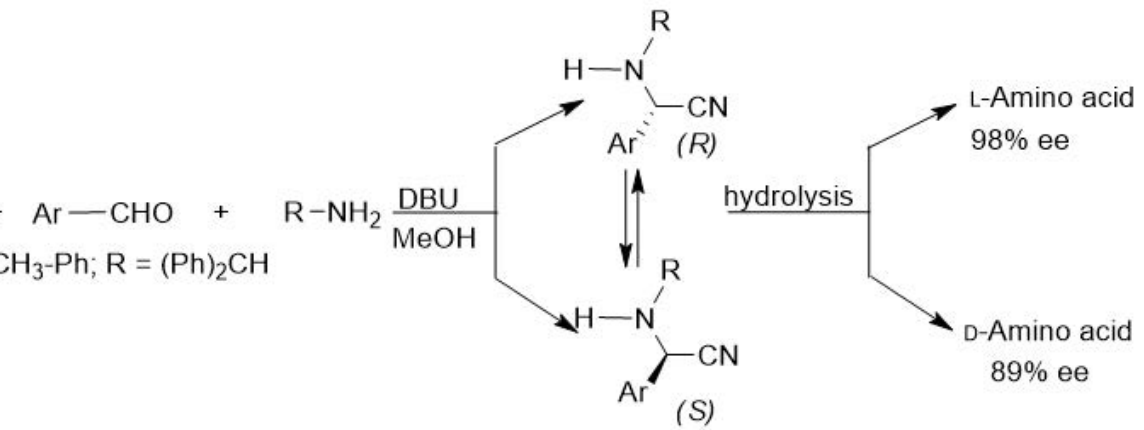
Scheme 15. Spontaneous resolution of racemic α -amino